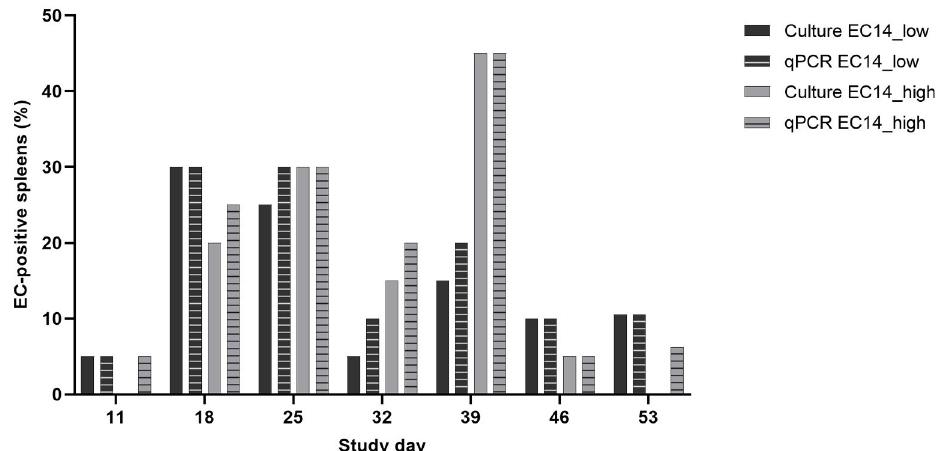
Fig 4. Comparison of bacteriological examination of the spleen via culture and real-time PCR. EC-positive spleens in groups EC14_low and EC14_high are shown per study day in %. Ct values below 36 were considered positive. All birds in the control group were found to be EC-negative in both detection methods. According to the Kappa coefficient, there was at least a substantial agreement ( κ > 0.61) on the EC-status at all study days and McNemar’s test revealed no significant differences in distribution of results. N = 20 per group and study day.